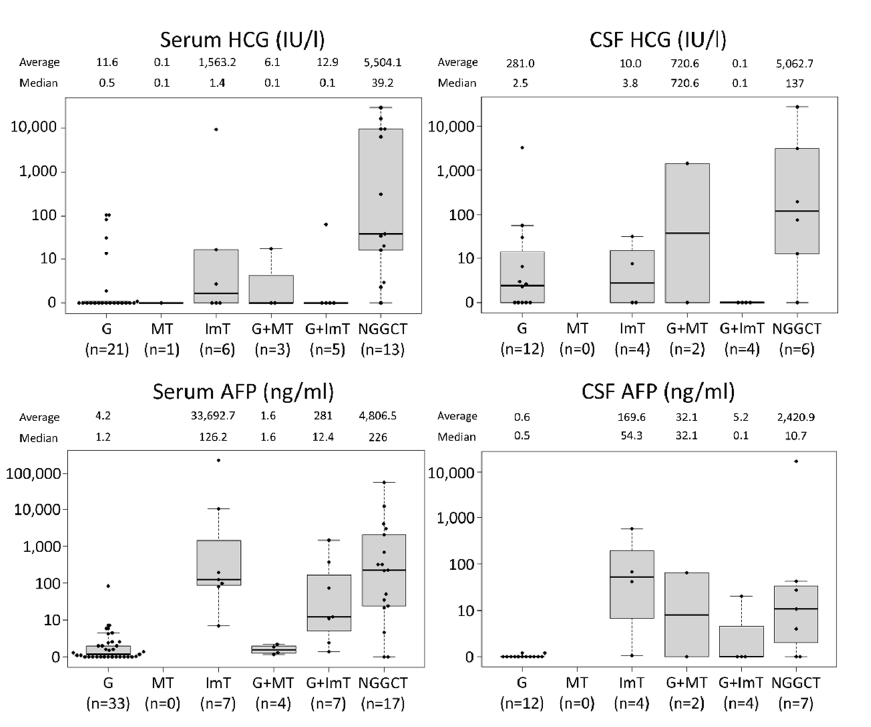
Figure 1. The values for serum and cerebrospinal fluid (CSF) human chorionic gonadotropin (HCG) and serum and CSF alpha fetoprotein (AFP) across histology in 77 cases that underwent resection (not biopsy) are shown. Germinomas were often accompanied by elevated HCG, while immature teratomas were often associated with elevated AFP. Abbreviations; G: germinoma, MT: mature teratoma, ImT: immature teratoma, NGGCT: non-germinomatous germ cell tumor. ImT was associated with modestly elevated HCG, although the values for all but one case were within the normal range. In contrast, most of the ImT in this cohort showed elevated AFP both in serum and CSF, similar to NGGCTs. This is reflected in the elevated AFP in mixed G + ImT cases.